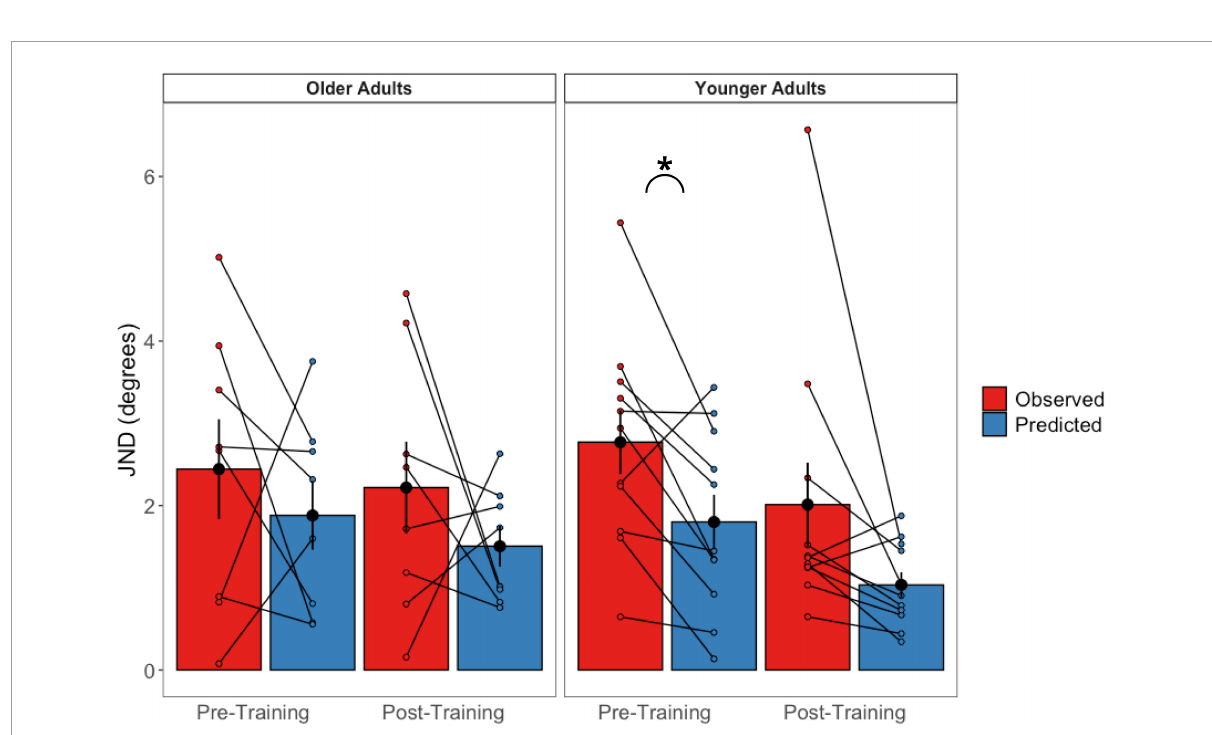
FIGURE9 Observed bimodal JNDs relative to predicted bimodal JNDs in older (left panel) and younger (right panel) adults. Black dots represent the averages and error bars represent standard errors. Colored dots represent individual participant’s scores. * p <